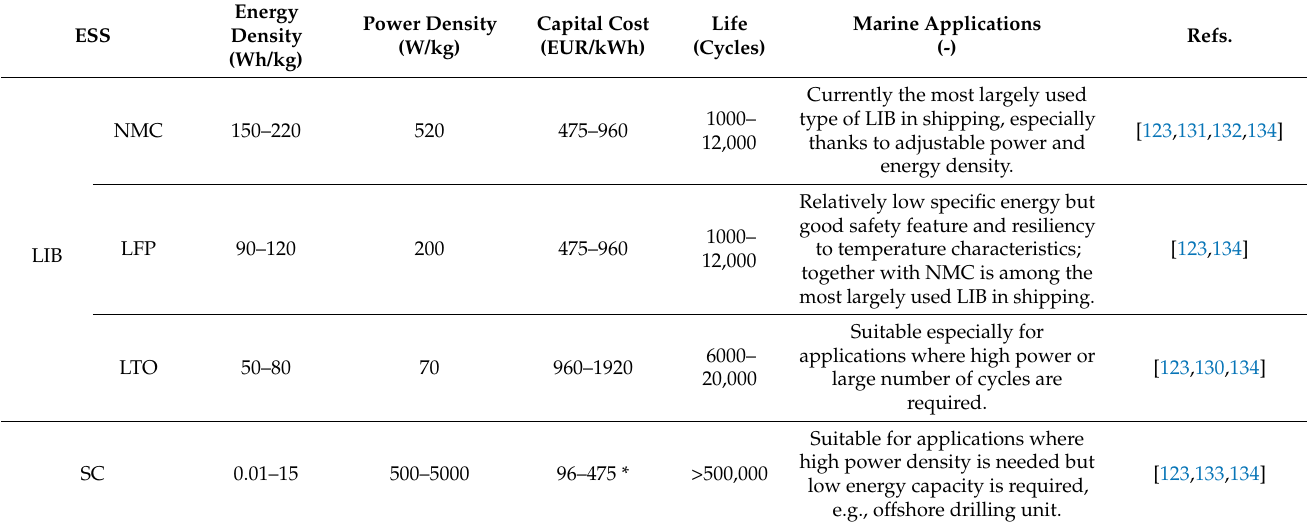
Table 5. Characteristics of the main ESSs for ship applications